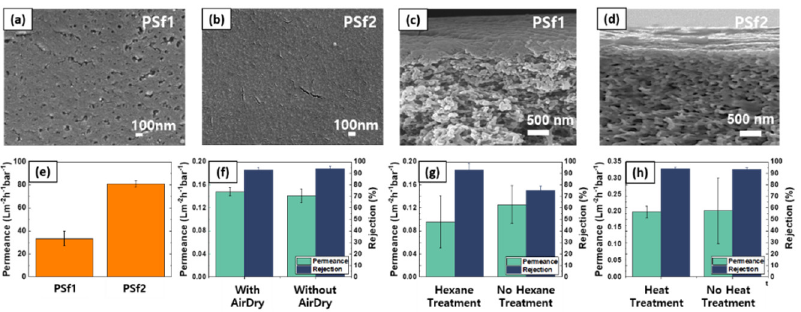
Figure 2. Polysulfone support membrane characterization and effect of post interfacial polymeriza- tion treatment. ( a – d ) surface and cross-sectional SEM images of PSf1 and PSf2, respectively; ( e ) pure water permeance of PSf1 and PSf2; ( f – h ) effects of air dry, hexane rinse, and heat treatment on TFC membrane water permeance and NaCl rejection, respectively. The membranes were tested with dead-end cell